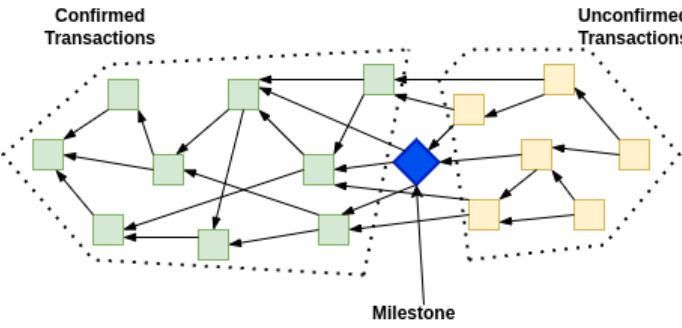
Figure 5. Milestone transaction confirming other transactions.